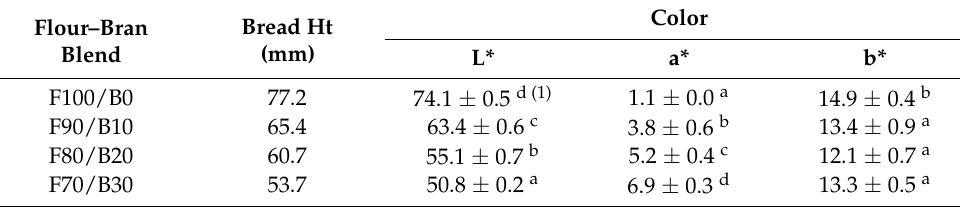
Table 3. Height and color of bread made from the flour–bran blends at different ratios.